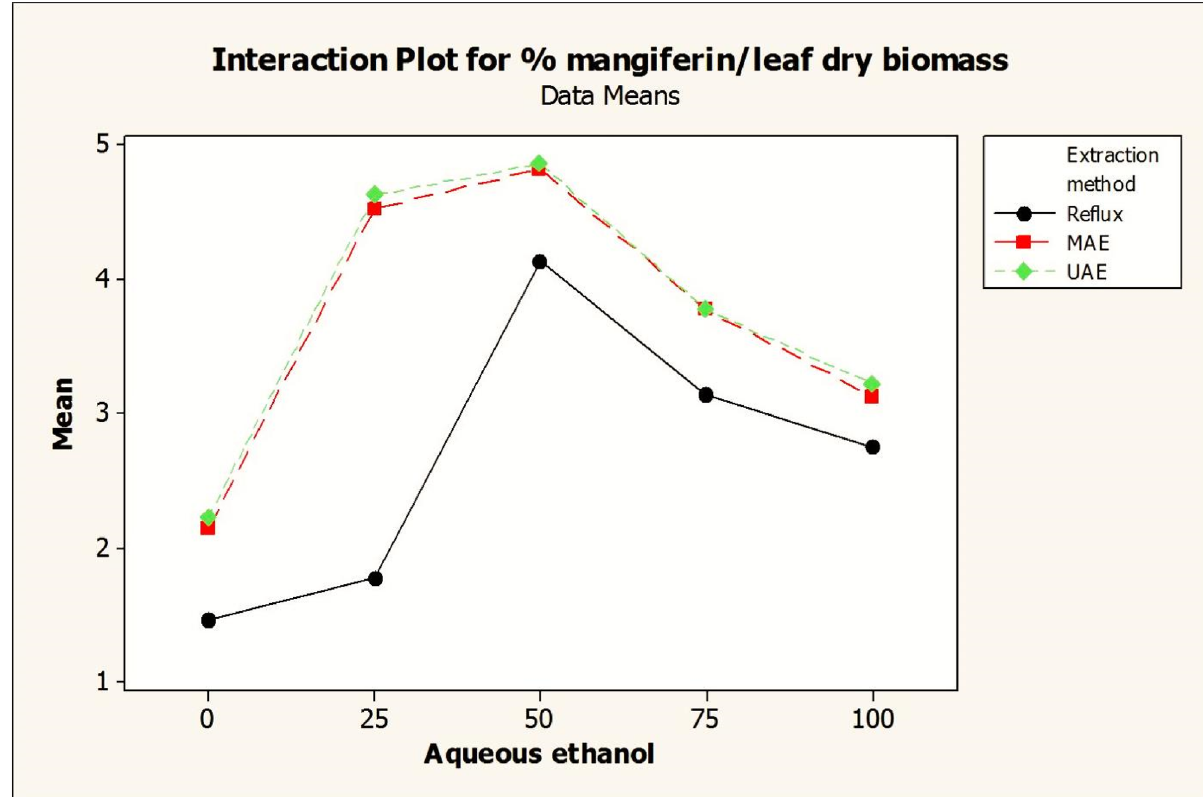
Figure 9. Interaction plot of extraction methods and aqueous ethanol composition for mangiferin yield from Swertia chirata leaves. Dot is the mean value of mangiferin